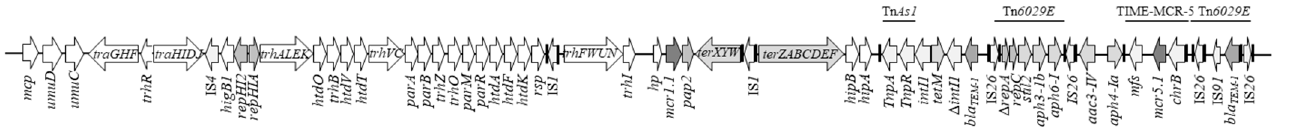
Figure 1. Major structural features of p77/84/18-IncHI2 (MZ666126). Predicted coding sequences are indicated in shades of grey arrows and oriented in the direction of transcription of each respective gene.